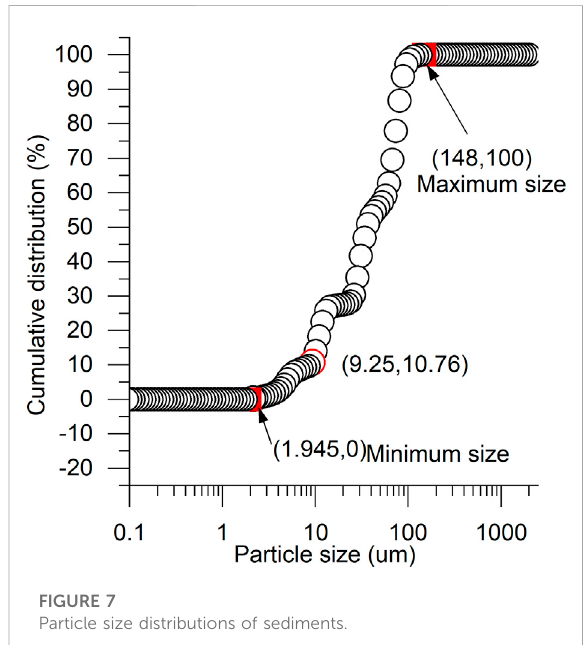
FIGURE 7 Particle size distributions of sediments.